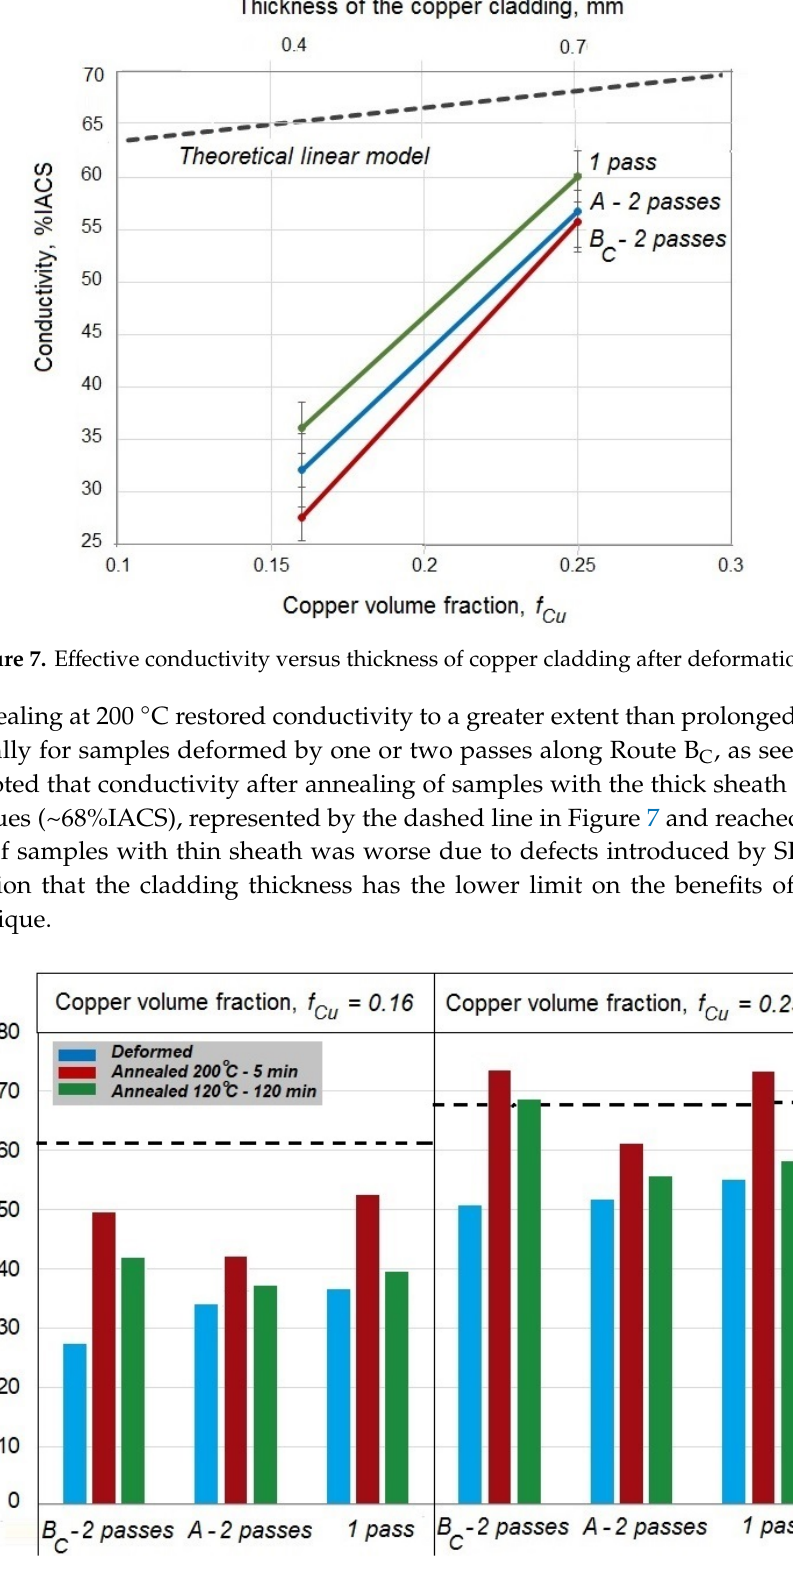
Figure 8. Effective conductivity after deformation and two annealing schedules for different thicknesses of copper cladding (the dashed line shows the theoretically predicted level of conductivity).